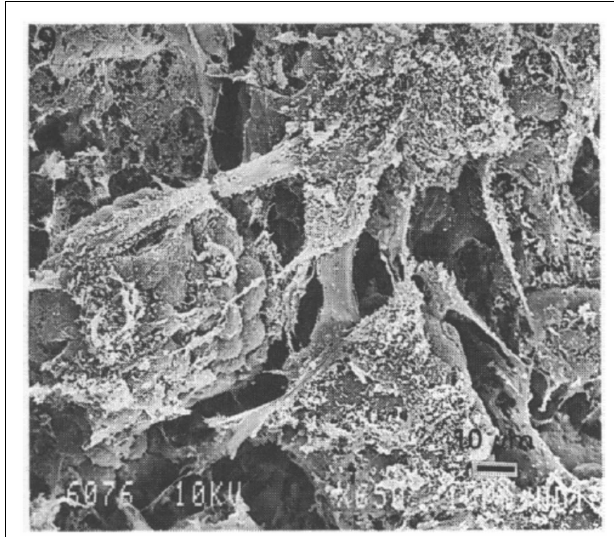
FIGURE 1 | Scanningelectron microscopy image of rabbit stomach mucosa showing surface cells and numerous bundles of fiber-like mucus strands . Scale bar 10 µ m. Reproduced from Nunn et al. (51) with permission fromWiley.